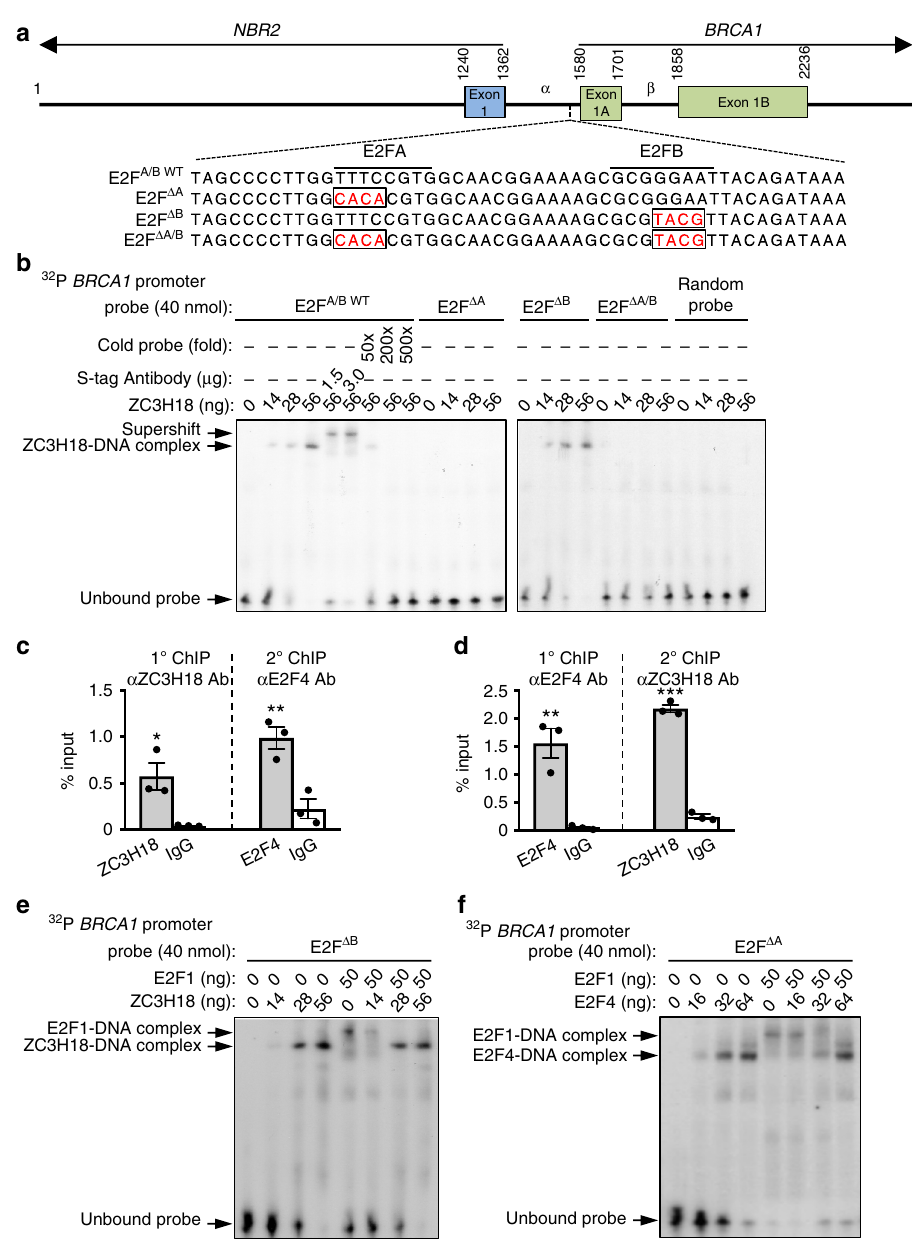
Fig. 6 ZC3H18 binds the BRCA1 promoter and inhibits E2F1 binding. a Schematic of the BRCA1 proximal promoter with E2FA and E2FB sites indicated. Nucleotide sequences of the DNA probes used in the electrophoretic mobility shift assays (EMSA). E2FA and E2FB mutation sites are indicated in open rectangles. b EMSA with puri fi ed recombinant SFB-ZC3H18 using BRCA1 promoter probe with wild-type sequence (E2FA/B WT ) or mutations in the E2FA site (E2F Δ A ), the E2FB site (E2F Δ B ), or both E2F sites (E2F Δ A/B ). A probe with randomly shuf fl ed sequences was used as negative control. For supershift assays, an anti-S-Tag monoclonal antibody, which binds the SFB tag in SFB-ZC3H18, was used. c , d ZC3H18 and E2F4 co-occupy the endogenous BRCA1 promoter. Sequential ChiP (ChIP-Re-ChIP) assays in OVCAR-8 cells using anti-ZC3H18 antibody for primary ChIP and anti-E2F4 antibody for secondary ChIP ( c ) and using anti-E2F4 antibody for primary ChIP and anti-ZC3H18 antibody for secondary ChIP ( d ). e EMSA with puri fi ed recombinant SFB-ZC3H18 and SFB-E2F1 using BRCA1 promoter probe with mutated E2FB site (E2F Δ B ). f EMSA with puri fi ed SFB-E2F4 and SFB-E2F1 using BRCA1 promoter probe with mutated E2FA site (E2F Δ A ). The images of EMSA in b , e , and f are representative of three independent experiments that gave similar results. Data in c and d are means ± SEM of three independent experiments. * p < 0.05, ** p < 0.01, *** p < 0.001, unpaired Student ’ s t-